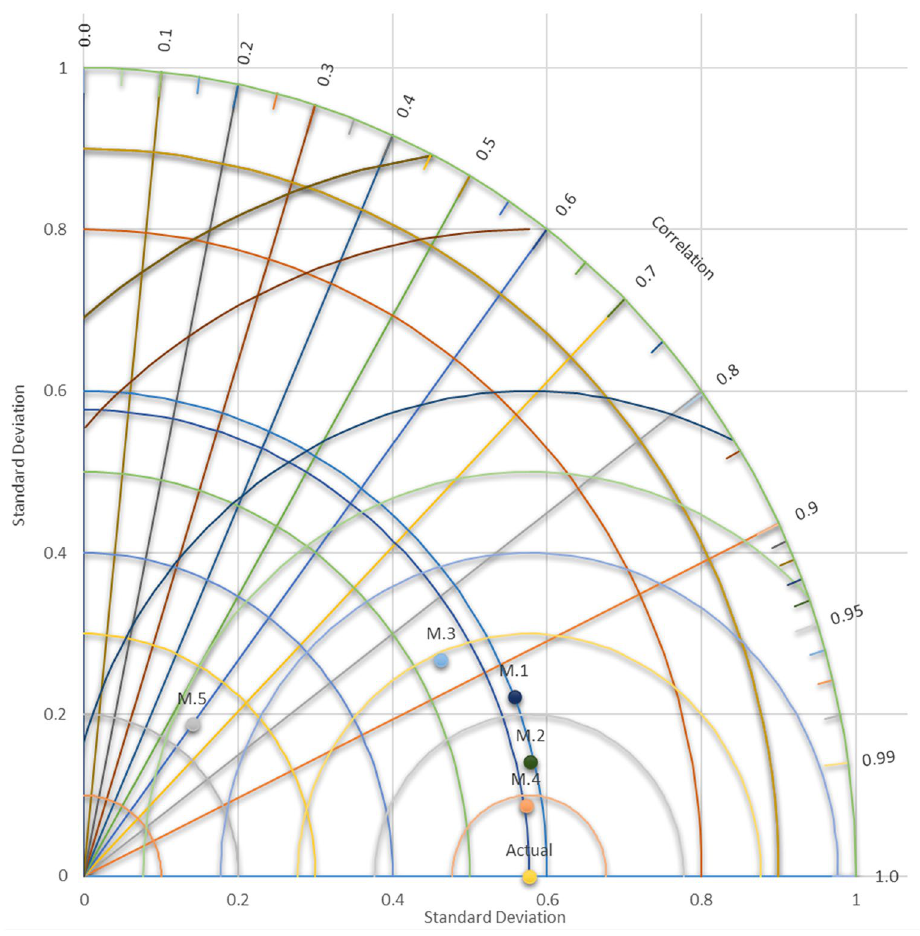
Figure 4. Taylor diagram for the proposed five models.